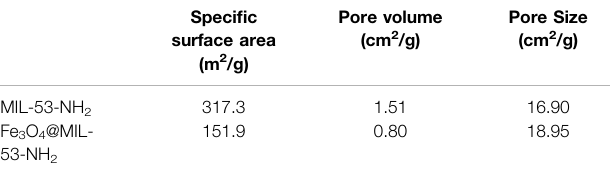
Figure 5C , the amounts of BPA and tetracycline adsorbed do not signi fi cantly change with an increase in NaCl concentration.